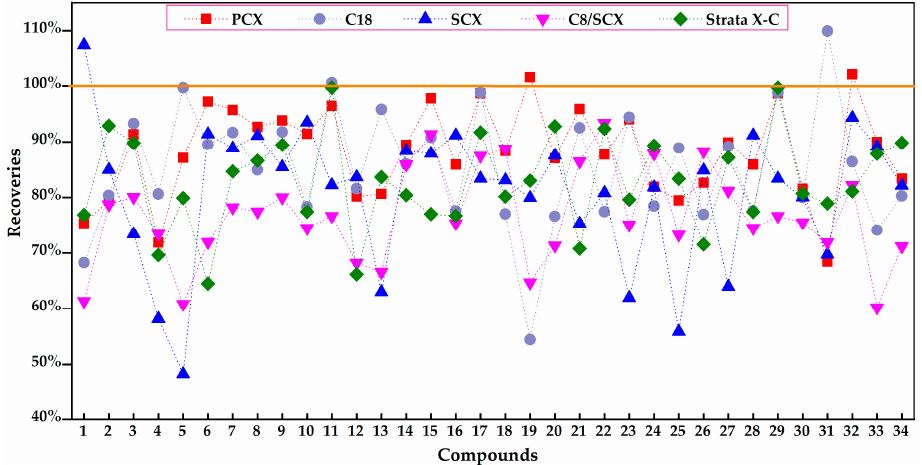
Figure 3. Effect of five different SPE cartridges on the recoveries of PAs. 1 : Retronecine, 2 :